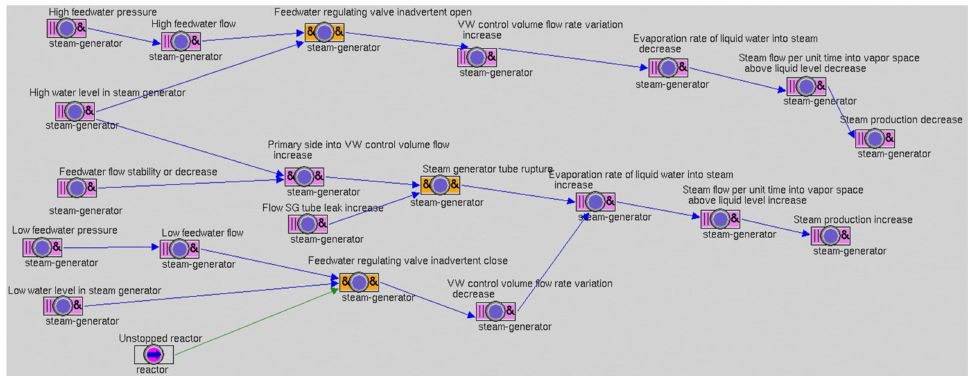
Figure 24. Design of the inference engine for the steam